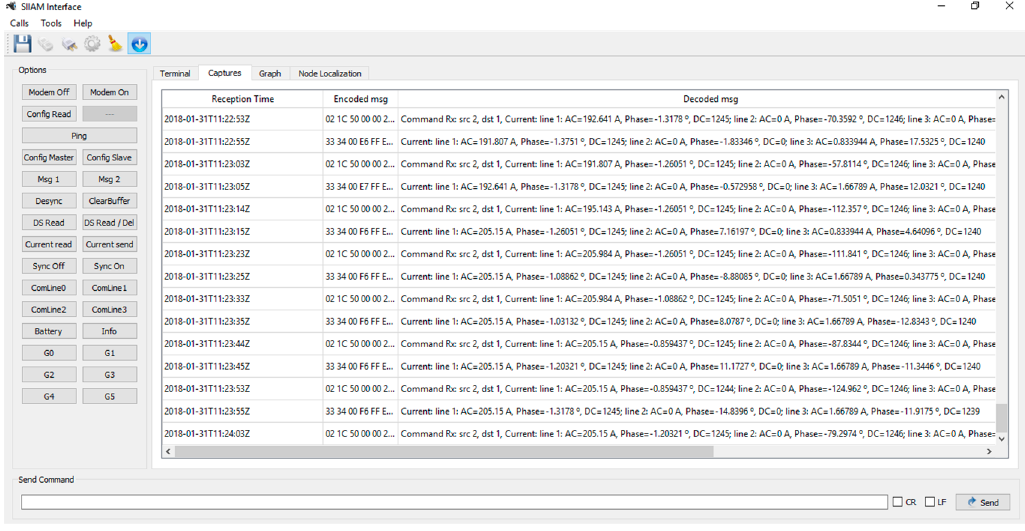
Figure 13. Computer interface. Frame captures.